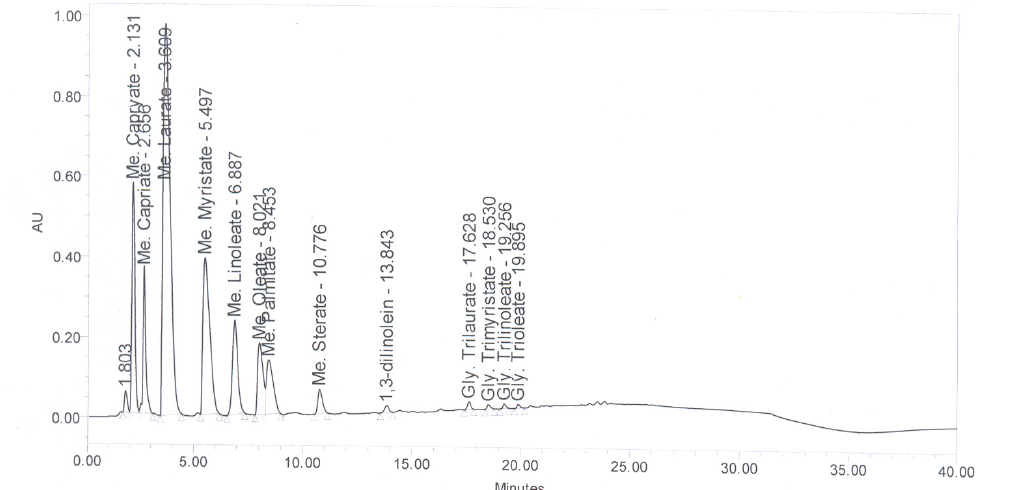
Figure 10. HPLC Chromatogram of coconut oil biodiesel in separating funnel